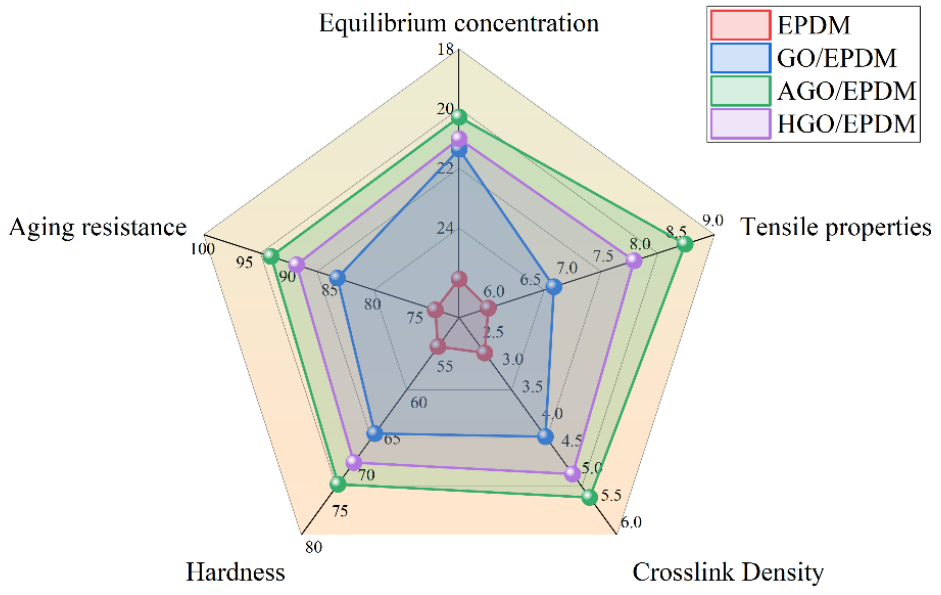
Figure 10. Performance polygon